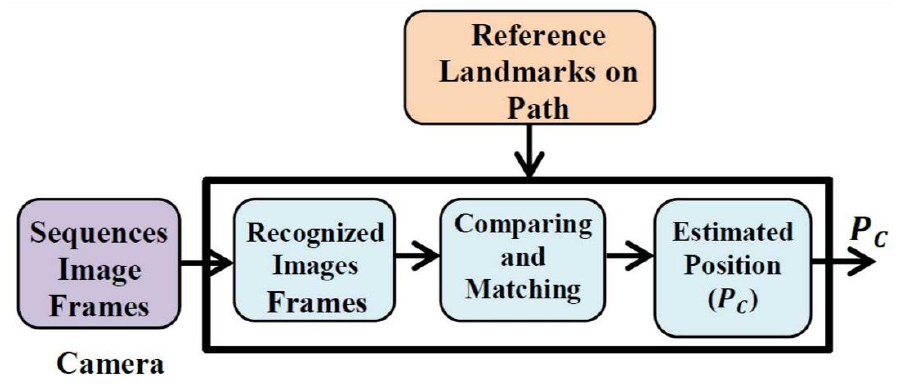
Figure 2. Block Diagram of the VNBM System.